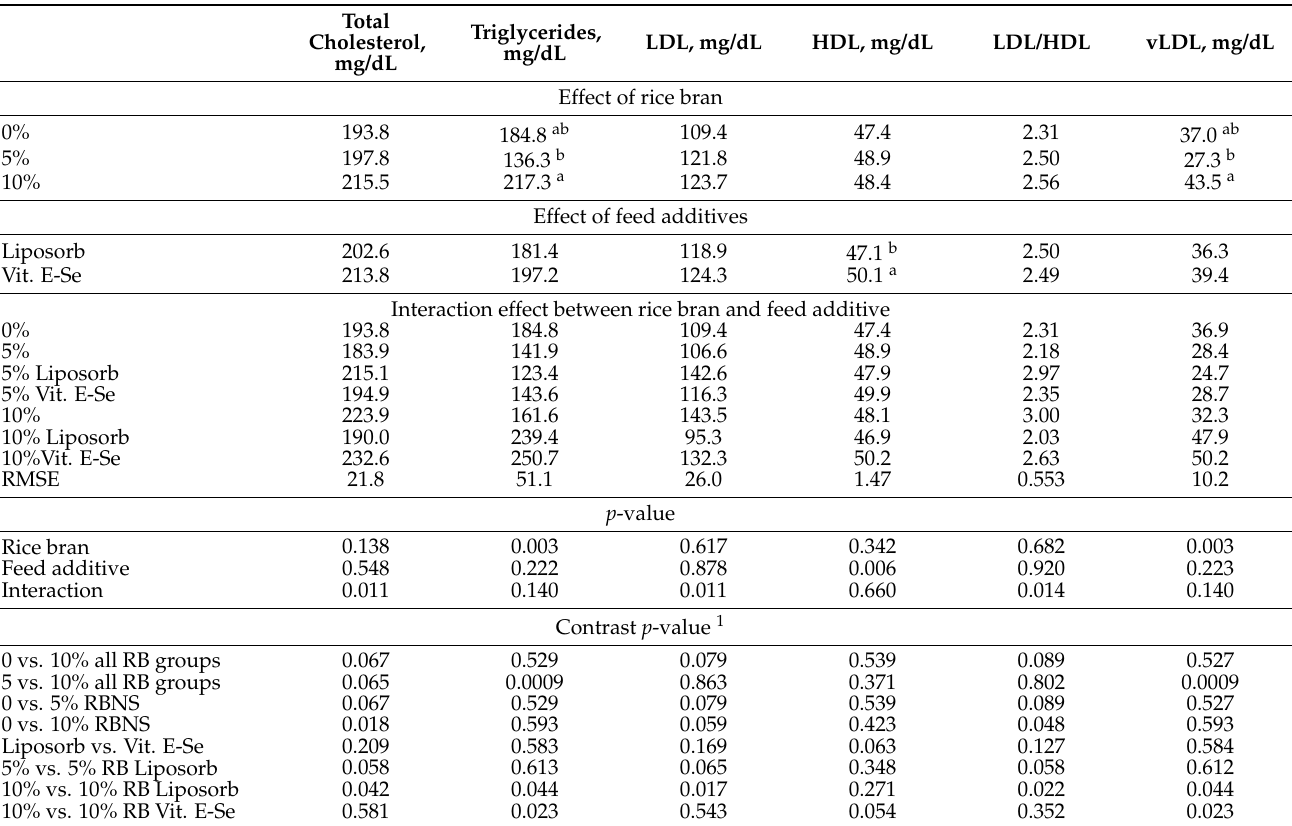
Table 6. Blood lipid profile of broiler chickens as affected by dietary rice bran treatments during the experiment.